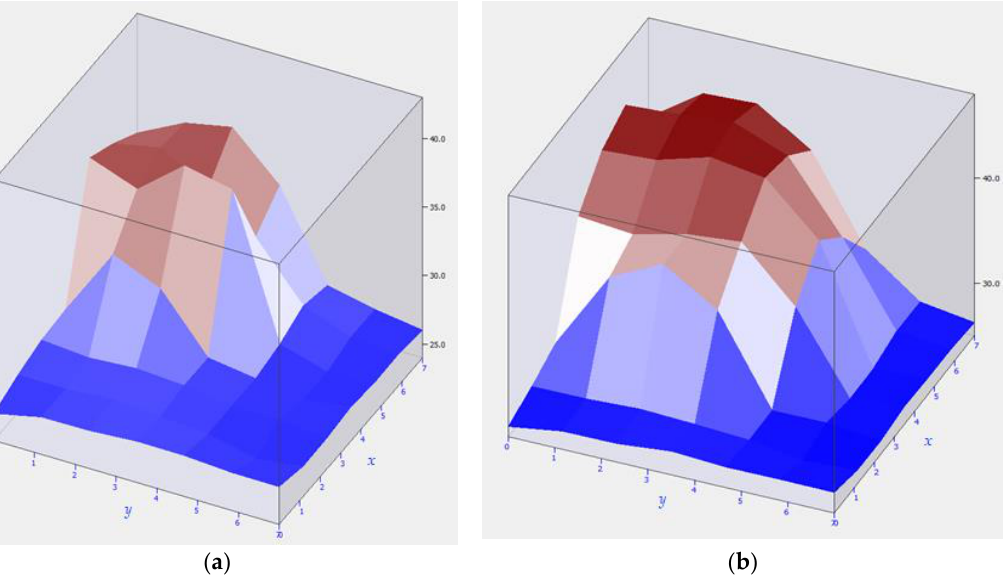
Figure 6. Overheating of the cathode part of the electrolysis cell bottom: ( a ) Hearth bottom with pronounced overheating of the right side (cathode 12); ( b ) Hearth bottom with pronounced overheating of both cathodes (cathodes 17–18).